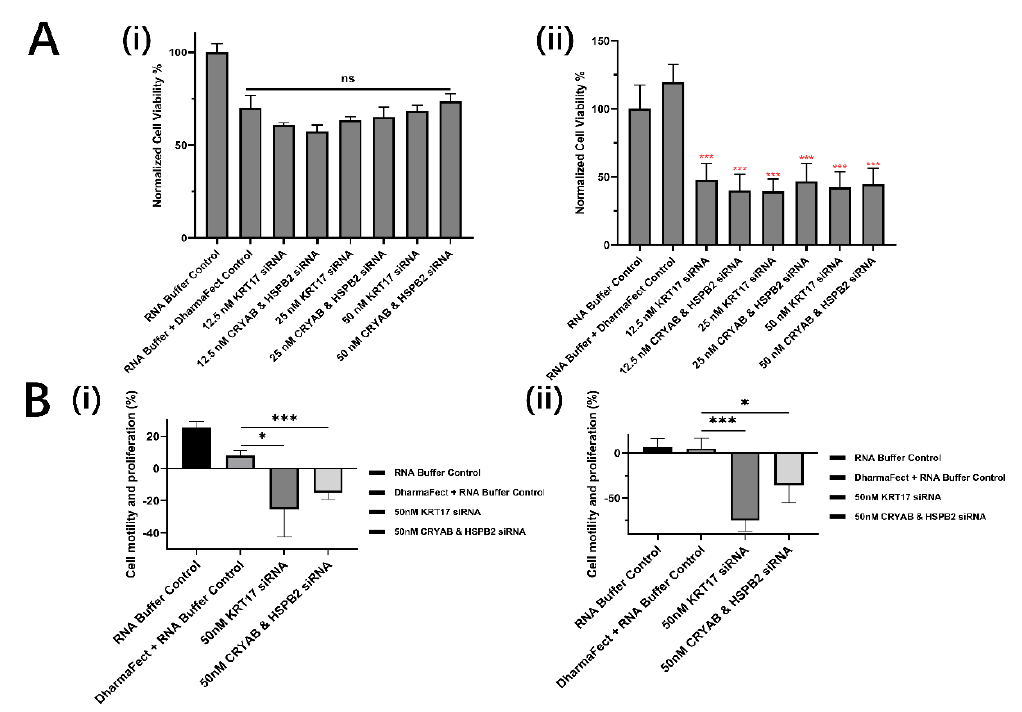
Figure 1. Measurement of chosen siRNAs’ effects on cell proliferation and mobilities. ( A ) MTT results comparing the cell relative survival rate and metabolism level of RD (i) and RH30 (ii) sarcoma cells after treated with different concentrations of KRT17-targeting siRNA, or CRYAB and HSPB2-targeting siRNA using DharmaFect as transfection reagent for 24 h ( n = 6). ( B ) Scratch assay results comparing the cell relative mobility of RD (i) and RH30 (ii) sarcoma cells after treated with 50 nM of KRT17- targeting siRNA, or CRYAB and HSPB2 -targeting siRNA using DharmaFect as transfection reagent for 24 h. Data are presented as mean ±SD for each individual cell line ( n = 3). Significance was tested using a two tailed t-test compared to the cells with only buffers for each cell line (ns: not significant, * p ≤ 0.05, *** p ≤ 0.001).